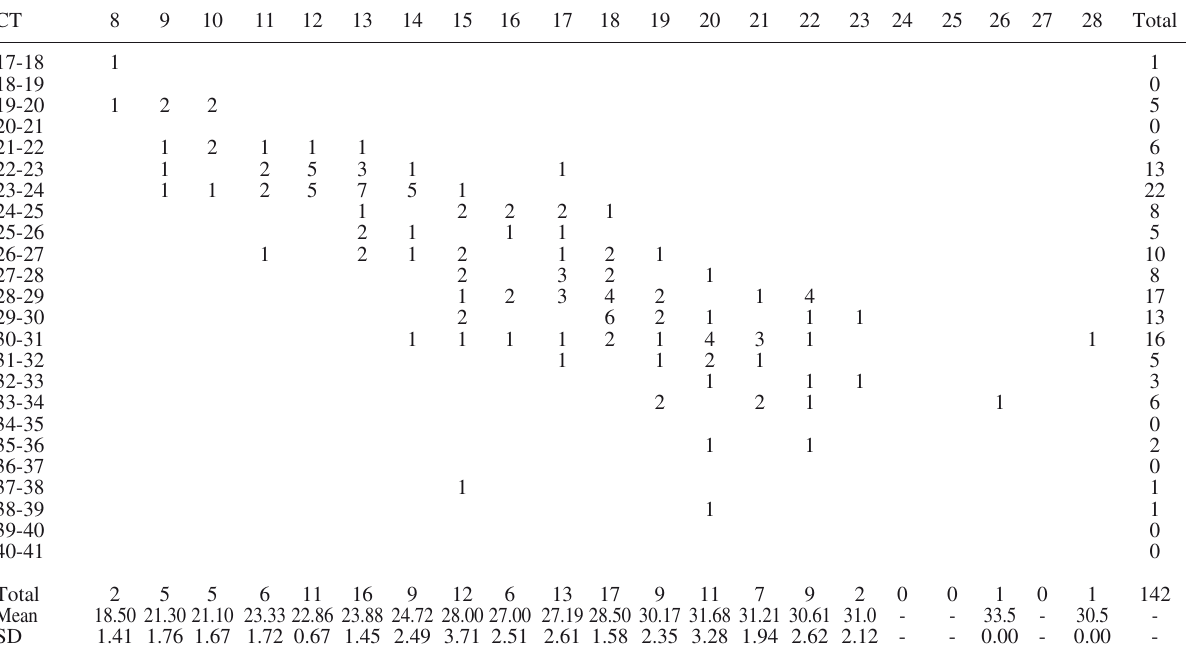
(whole otolith readings: χ 2 =58.59, df=3; backcalcula- tion: χ 2 =72.54, df=3; combined: χ 2 =80.88, df=3). The